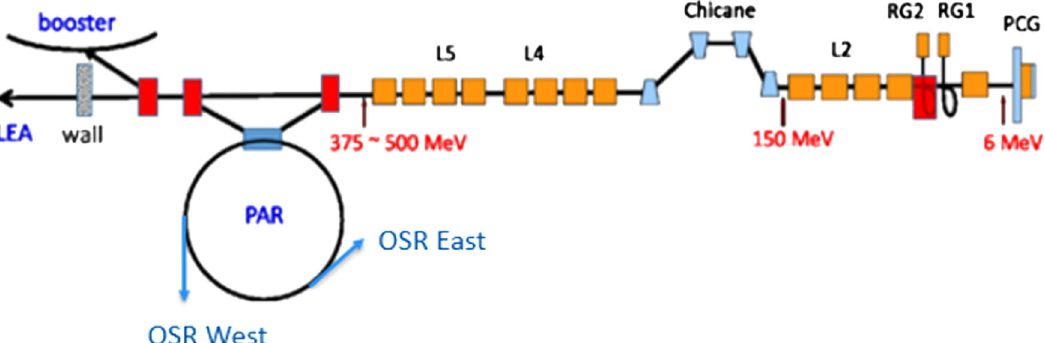
FIG. 1. Schematic layout of the APS S-band linac structures (L#) with the photocathode gun (PCG), rf thermionic guns (RG1 and RG2), the PAR injector chain, and the optical synchrotron radiation (OSR) ports with optical transport out of the tunnel. The CMOS camera and streak camera use the OSR West source. (Adapted under Creative Commons license CC-BY 4.0 from Ref.